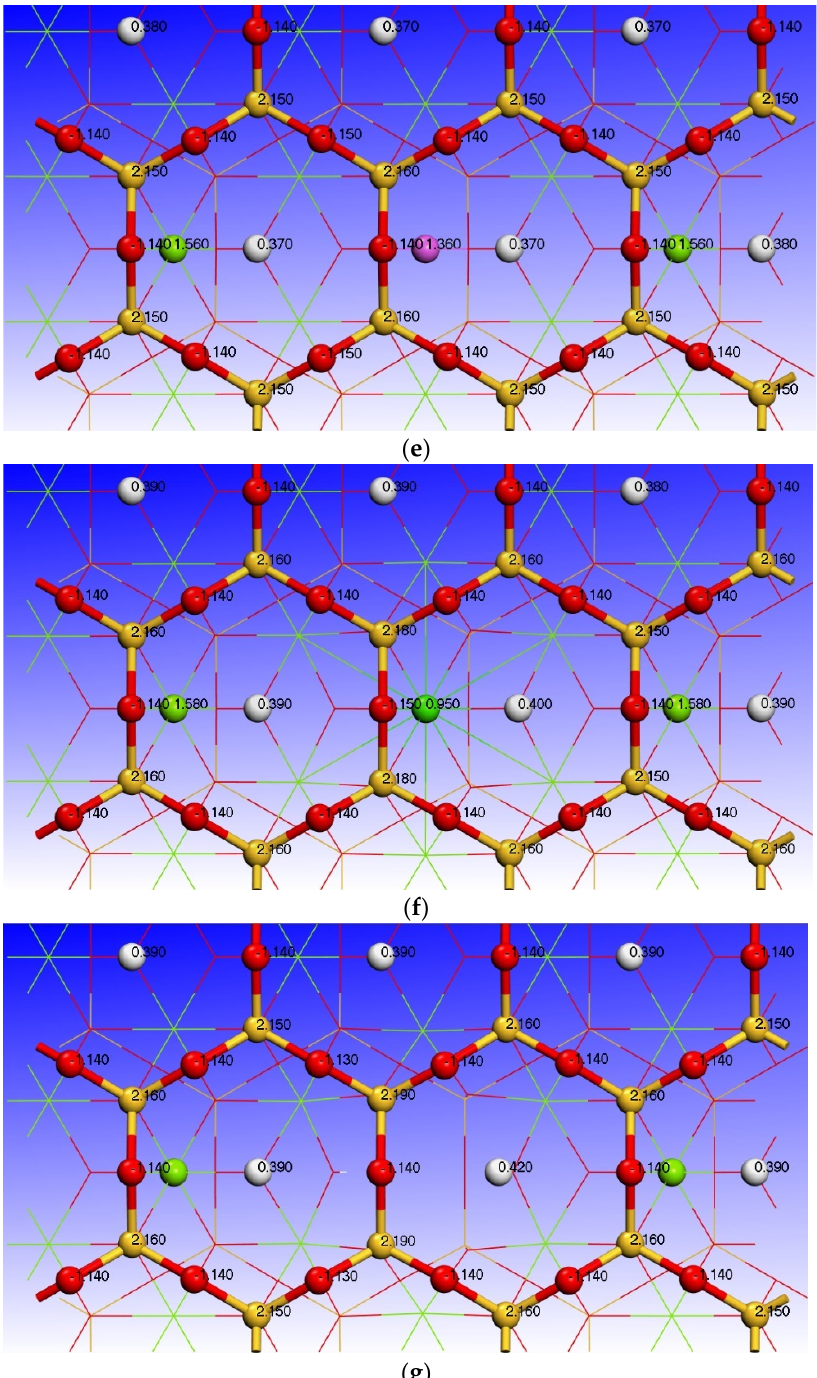
Figure 4. Atomic charge distribution on the point defect talc surface: ( a ) ideal surface, ( b ) Fe impurity defect surface, ( c ) Mn impurity defect surface, ( d ) Ni impurity defect surface, ( e ) Al impurity defect surface, ( f ) Ca impurity defect surface, and ( g ) Mg vacancy surface.